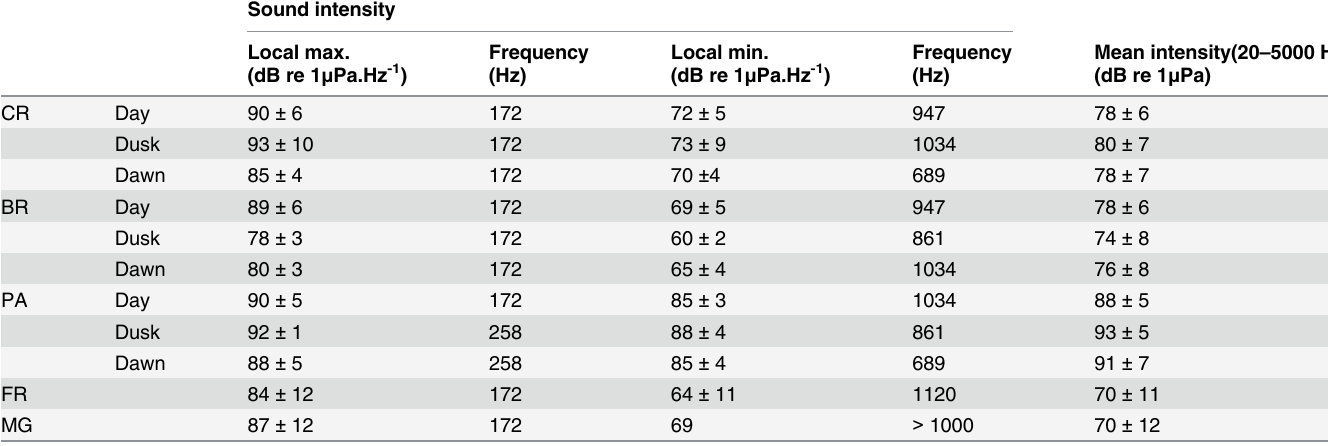
Table 1. Intensities and corresponding frequencies of local maxima and minima for habitats recorded at the North coast in 2011. Sound intensity Local